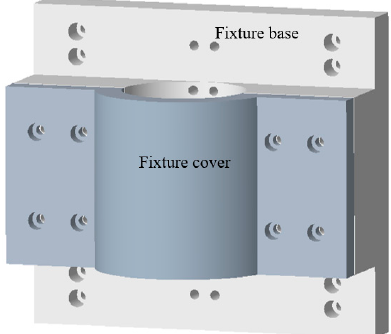
Figure 5. The structure of the tool fixture.